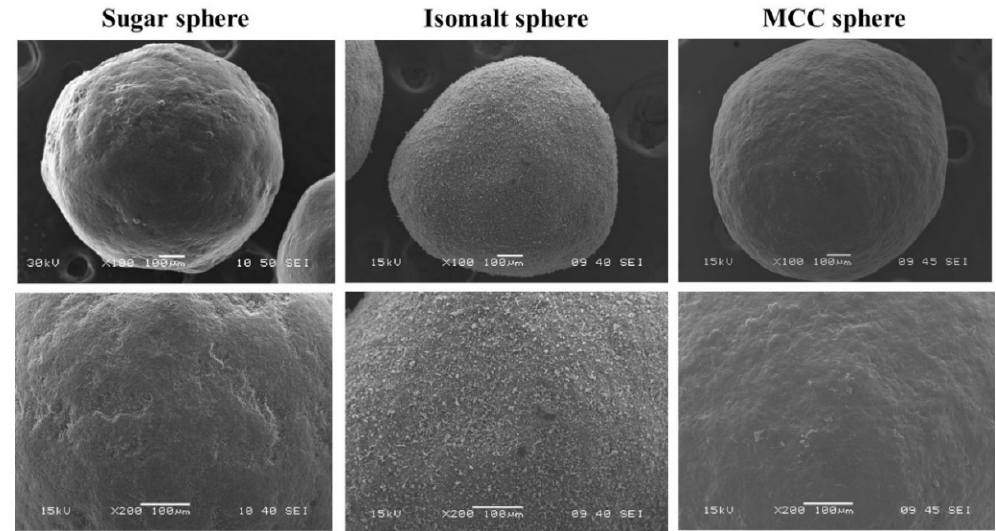
Figure 6. Scanning electron microscopic images of various inert cores (JEOL JSM-6380 LA).